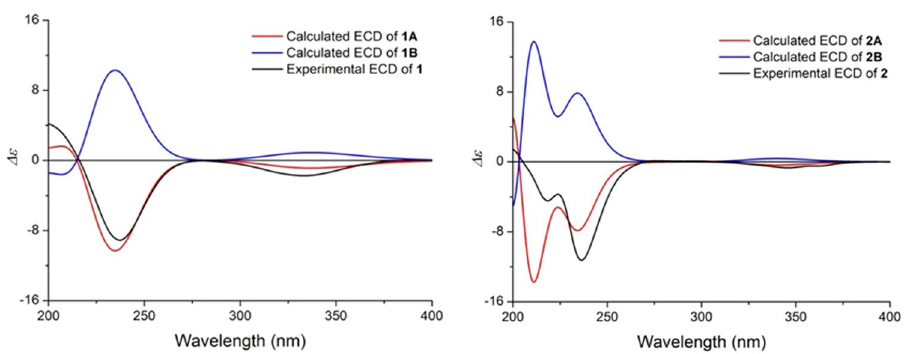
Figure 3. Experimental ECD spectrum of 1 and 2 and calculated ECD spectra of 1A, 1B, 2A and 2B in